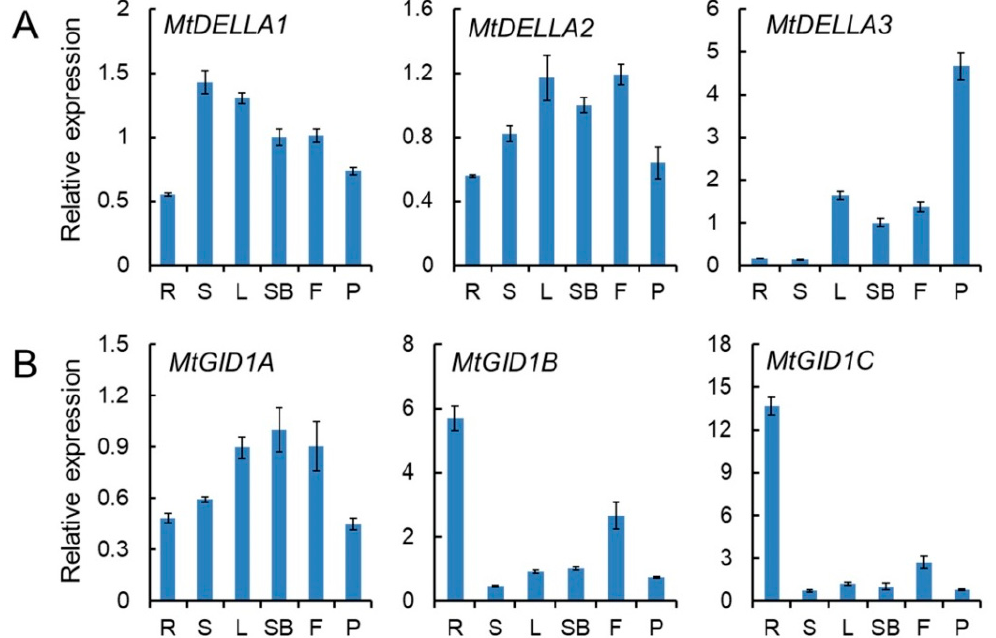
Figure 5. Expression patterns of MtDELLA ( A ) and MtGID1 ( B ) genes in six different tissues. R, roots; S, stems; L, leaves; SB, shoot buds; F, flowers; P, pods. The level of expression was normalized to M. truncatula UBI gene. Error bars represent SD for three biological replicates.